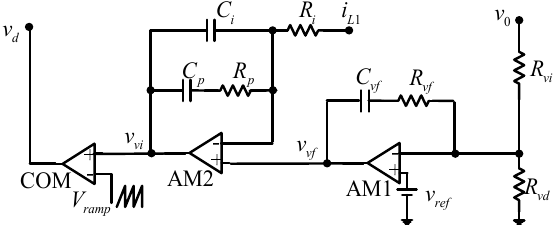
Figure 7. Circuit schematic for the average current mode controller.